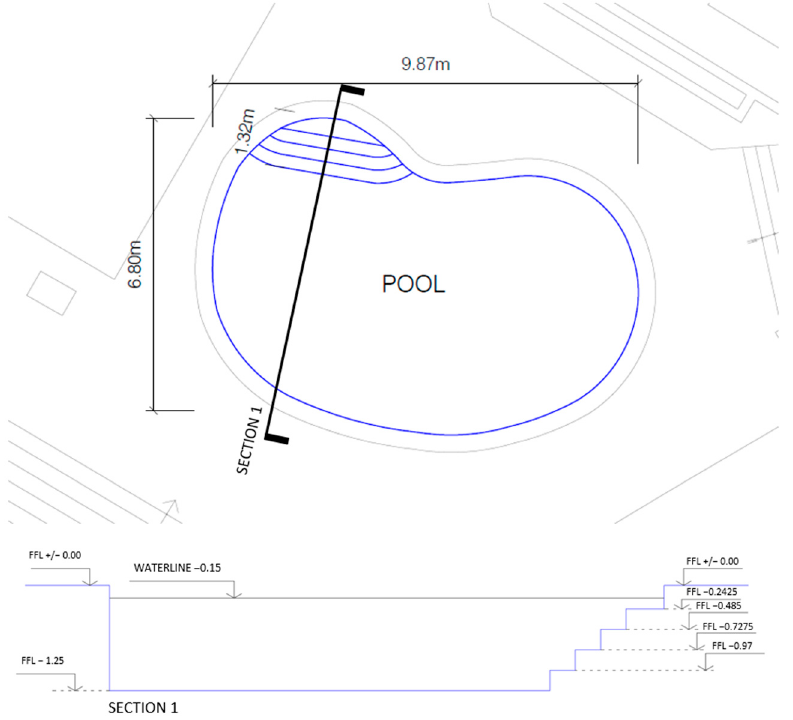
Figure 3. Plan and section using measurements from the topographic equipment.